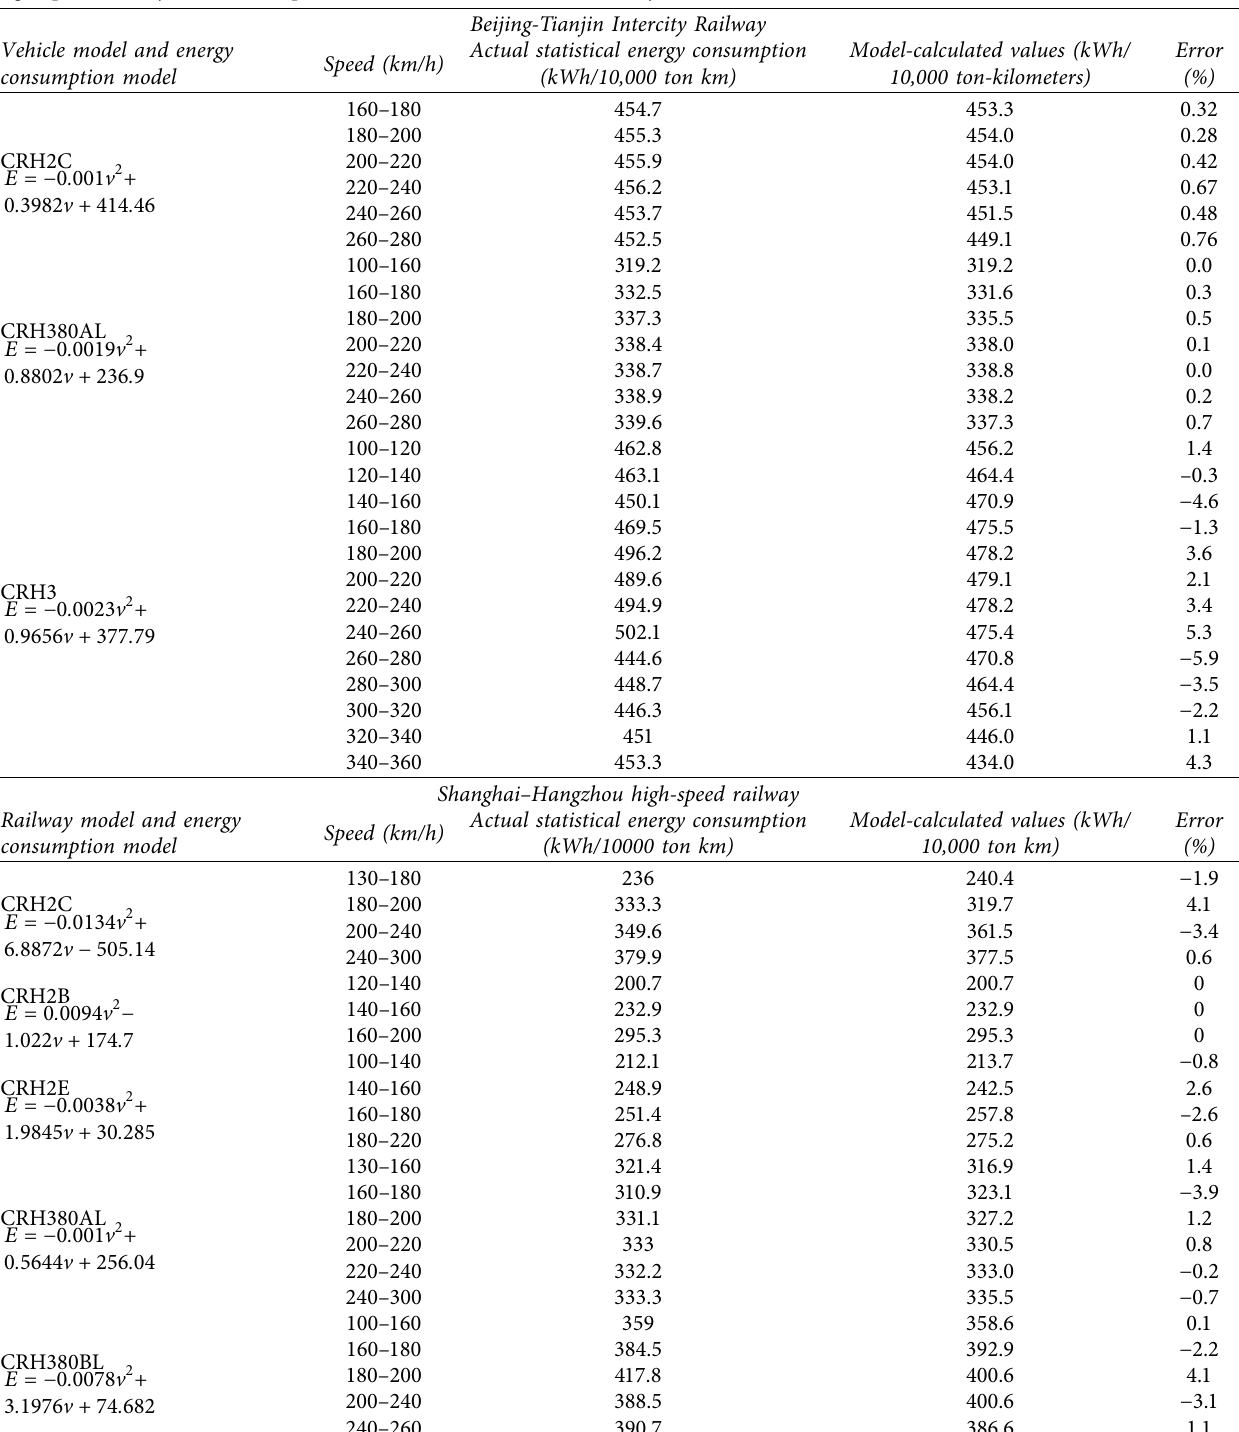
Table 2: Actual energy consumption values of different EMU models on the Beijing–Tianjin intercity railway and Shanghai–Hangzhou high-speed railway at different speed levels and the values calculated by the